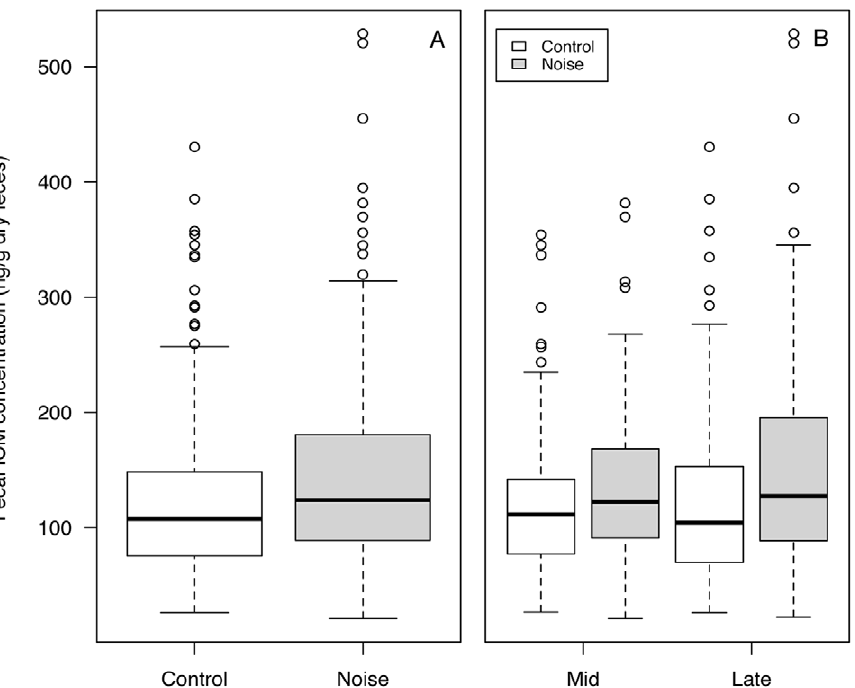
Figure 2. FCM concentrations from control and noise-treated groups. Data shown (A) pooled by season and (B) for mid and late season samples. Horizontal line represents the median value, box ends represent upper and lower quartiles, whiskers represent maximum and minimum values and open circles represent outliers. Plots present measured FCM values, not model output, which is presented in Table 2. doi:10.1371/journal.pone.0050462.g002 PLOS ONE |